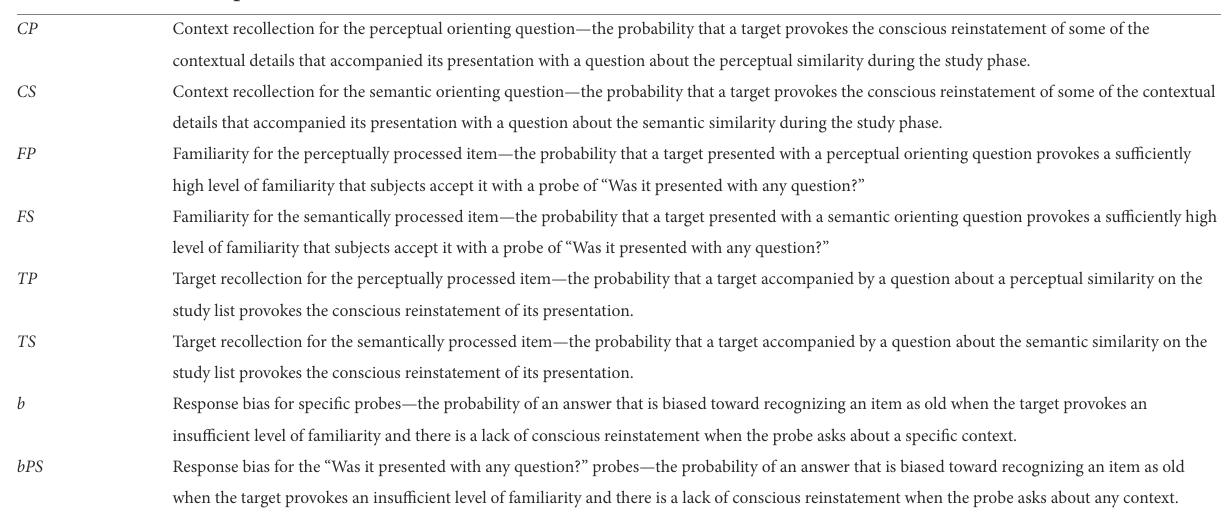
TABLE 1 Parameters of the multinomial dual-recollection model used in Experiment 1.